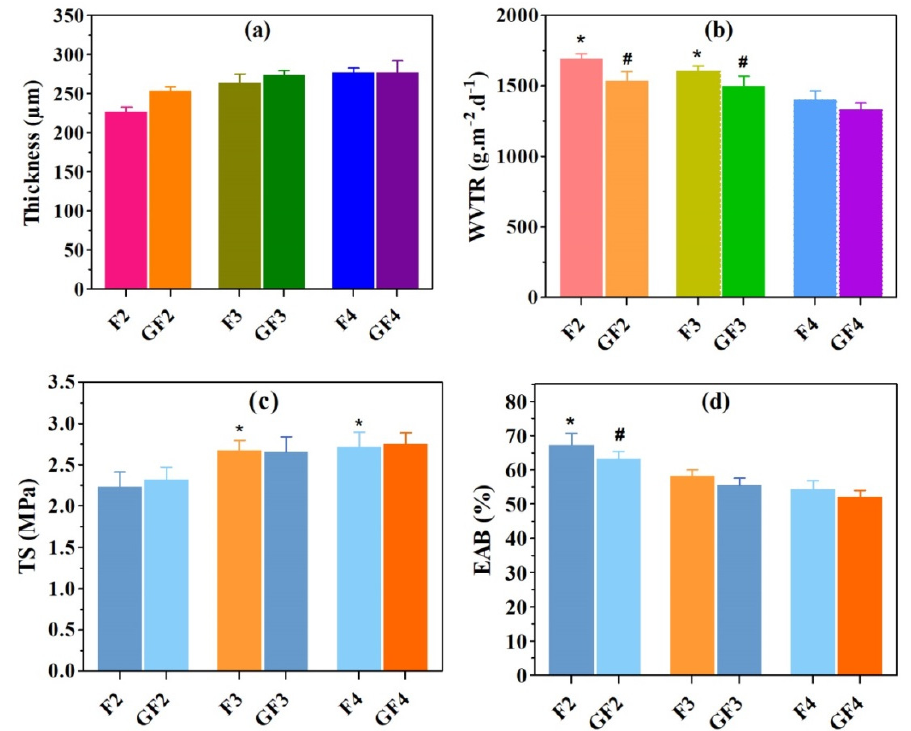
Figure 1. Results of ( a ) thickness, ( b ) water vapor transmission rate (WVTR), ( c ) tensile strength (TS), and ( d ) elongation at break (EAB) of the arabinoxylan (AX)-sodium alginate (SA) films (mean ± SD, n = 3). * and # show statistically significant differences ( p < 0.05) from parallel blank and gentamicin (GS)-loaded films.